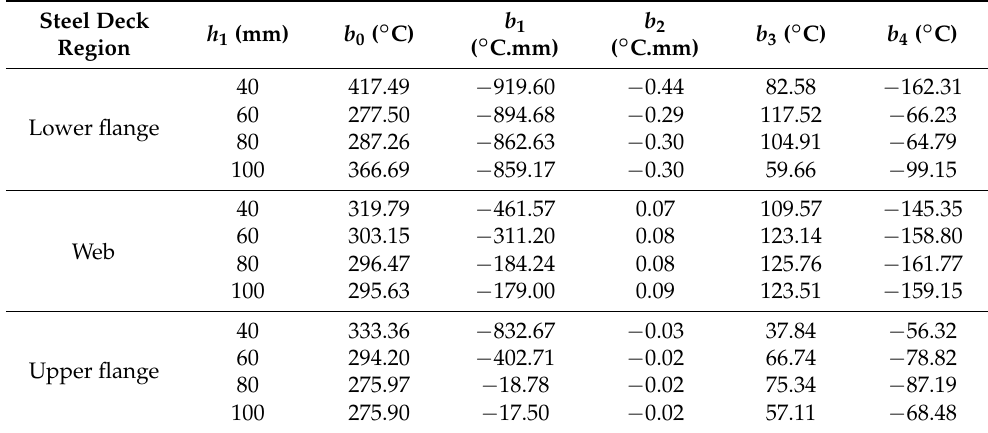
Table 6. New coefficients proposed to determine the temperature in steel deck under fire curve Parametric 4 and for the fire rating of 60 min.